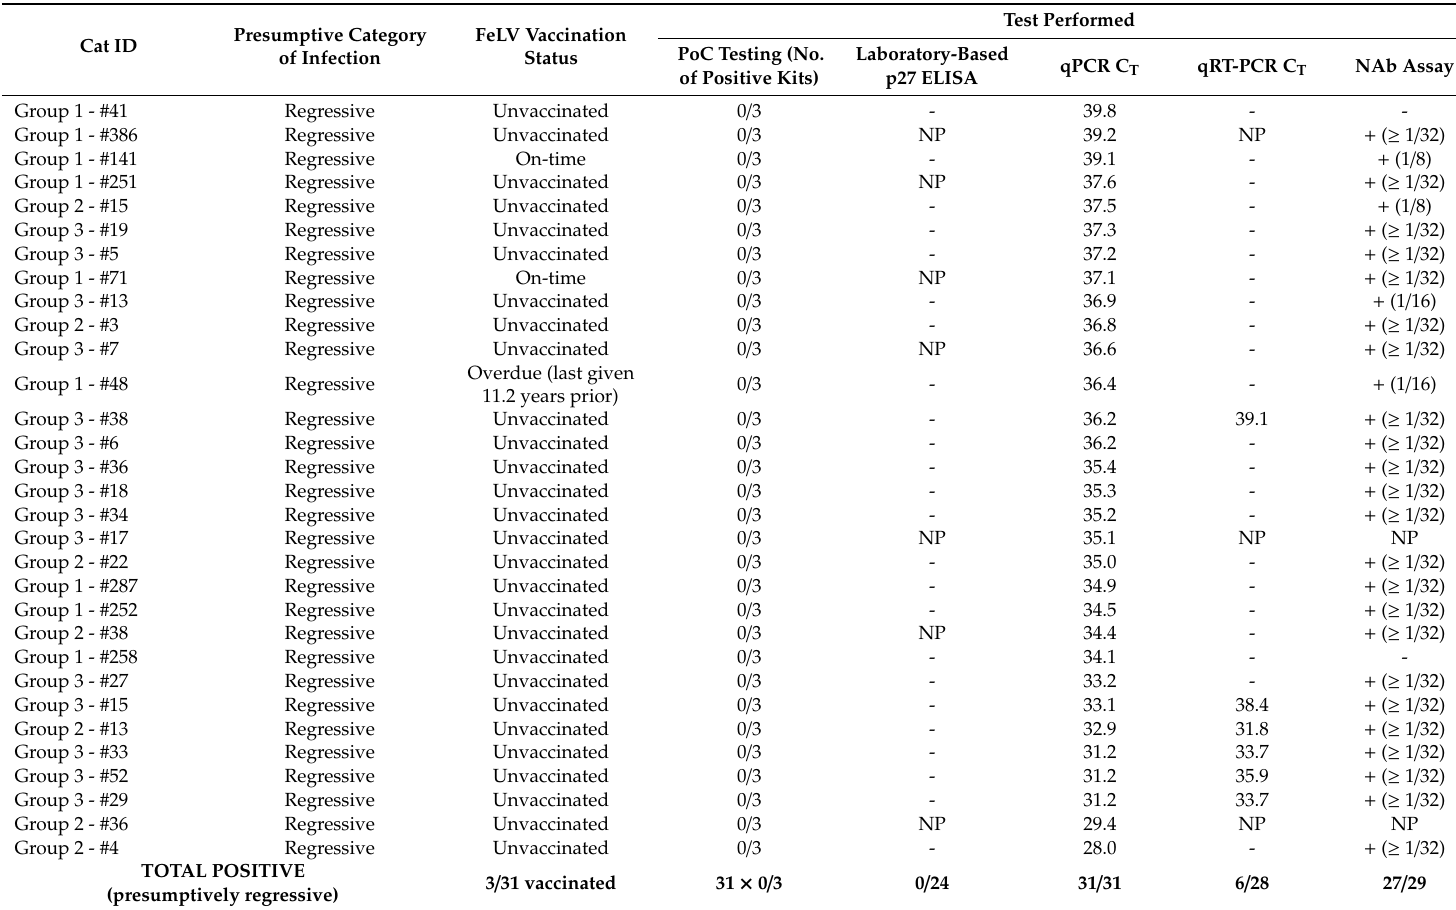
Table 4. Summary of individual results for presumptively regressively-infected ( n = 31) and presumptively progressively-infected cats ( n = 21), arranged in descending order of C T value for qPCR testing (i.e., from lower levels of FeLV provirus to higher levels of FeLV provirus). Occasionally, there was insu ffi cient sample volume for laboratory-based p27 ELISA, qRT-PCR, and NAb testing. + = positive result, − = negative result, NP = not